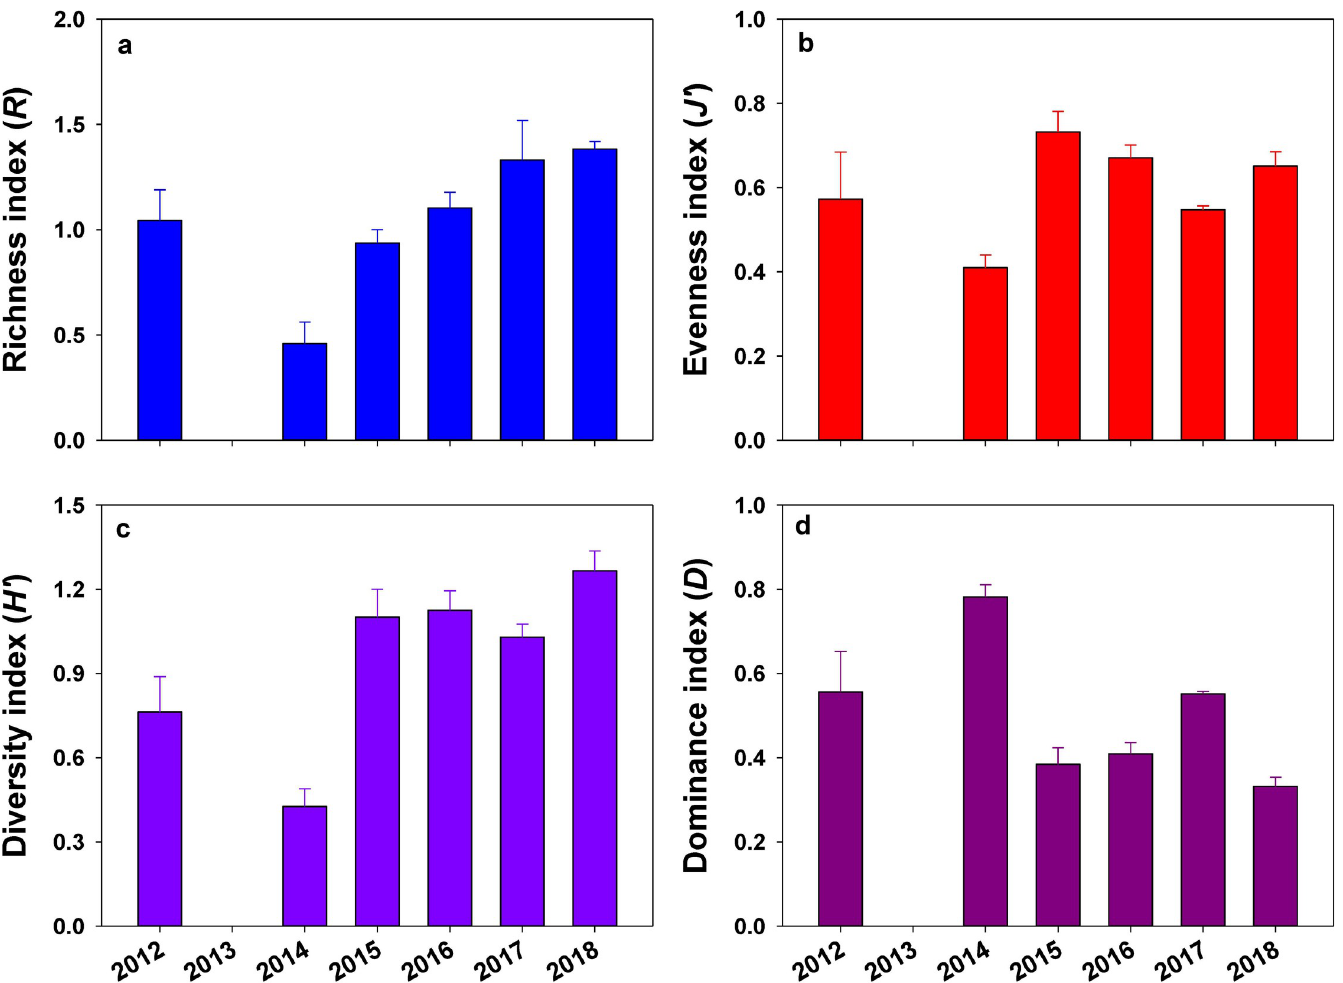
Fig 4. Diversity indices. Margalef’s Richness index ( R ; a), Pielou’s Evenness index ( J’ ; b), Shannon’s Diversity index ( H’ ; c) and Simpson’s Dominance index ( D ; d) of marine benthic organisms at the study site in Terra Nova Bay, Antarctica. Values are means ± SE (n = 12–18). The arrow indicates the construction period of Jang Bogo station (time of